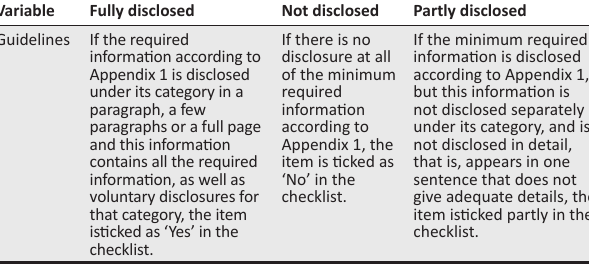
TABLE 1: Content analysis